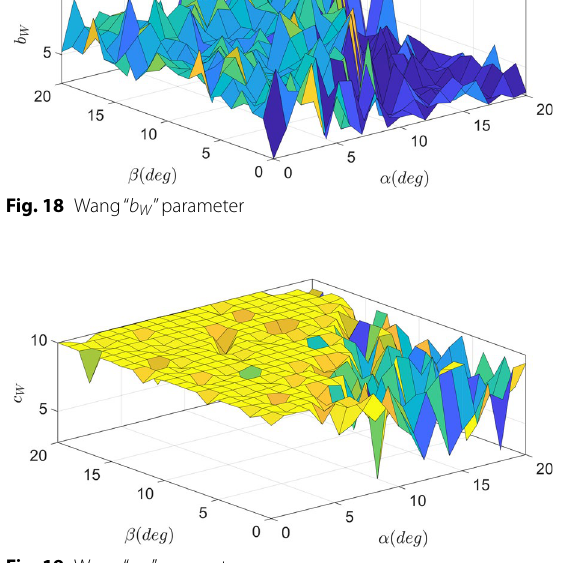
Fig. 19 Wang “ c W ”